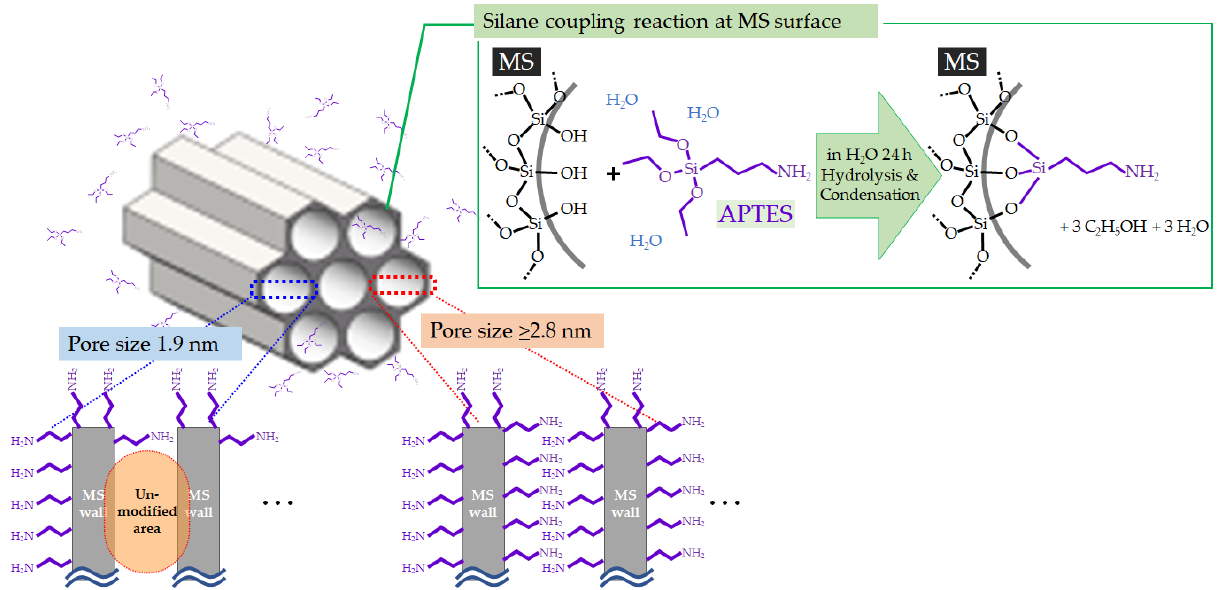
Figure 3. SSA ( a ) and pore volume ( b ) of MSs with different pore sizes before and after the surface Figure 3. SSA( a )andporevolume( b )ofMSswithdifferentporesizesbeforeandafterthesurfacemodification. modification.